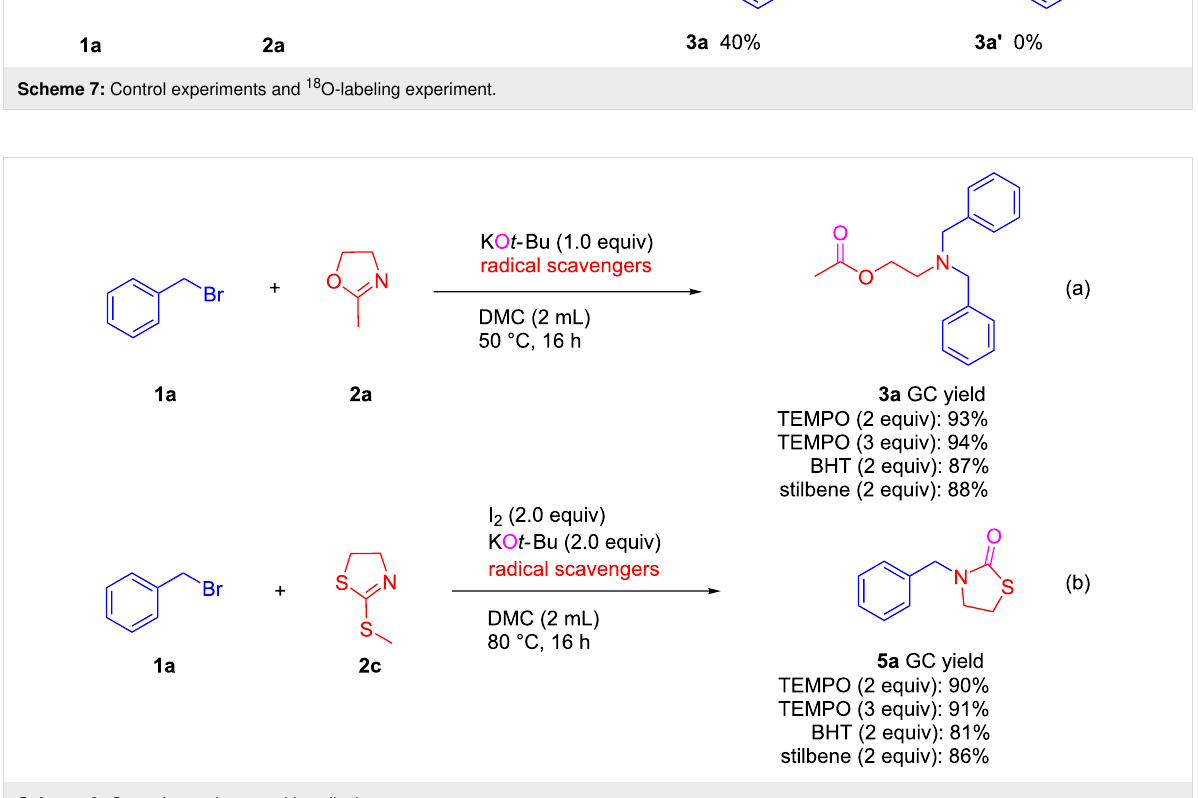
Scheme 8: Control experiments with radical